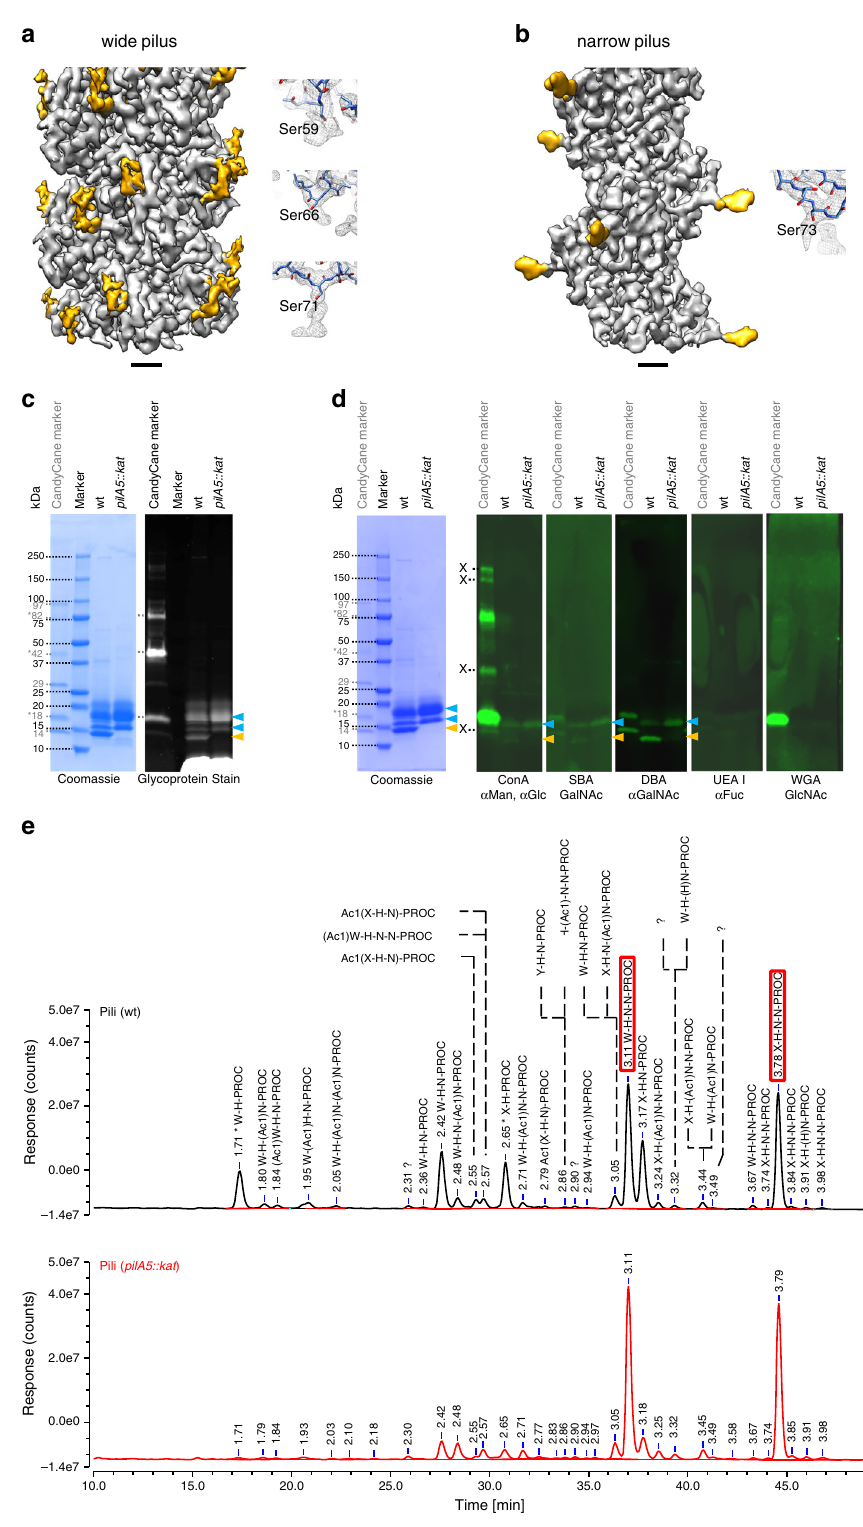
the highest amount, and therefore that most likely account for the electron density in our maps, are W-H-N-N and X-H-N-N (Supplementary Fig. 8). X represents an unknown carbohydrate unit of 346 Da and does not correspond to any previously reported bacterial structures. Comparison of these data and the corresponding GU (glucose unit) values 43,44 to the data